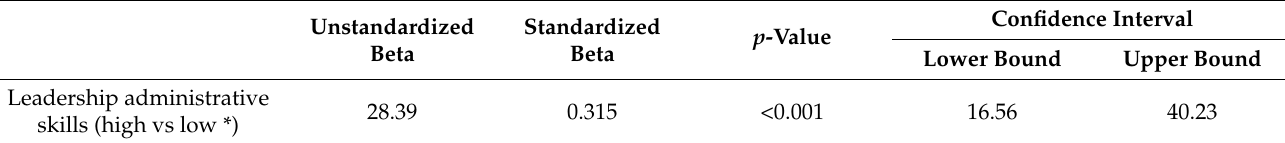
Figure 3. Mean values of the work ethics scale according to high/low conceptual leadership skills adjusted for age, gender, education level, and years of experience. A linear regression model was performed, taking the ethical attitudes total scale as the dependent variable. The results showed that higher administrative leadership skills (Beta = 28.39) were significantly associated with a higher ethical attitudes scale (Table 5).